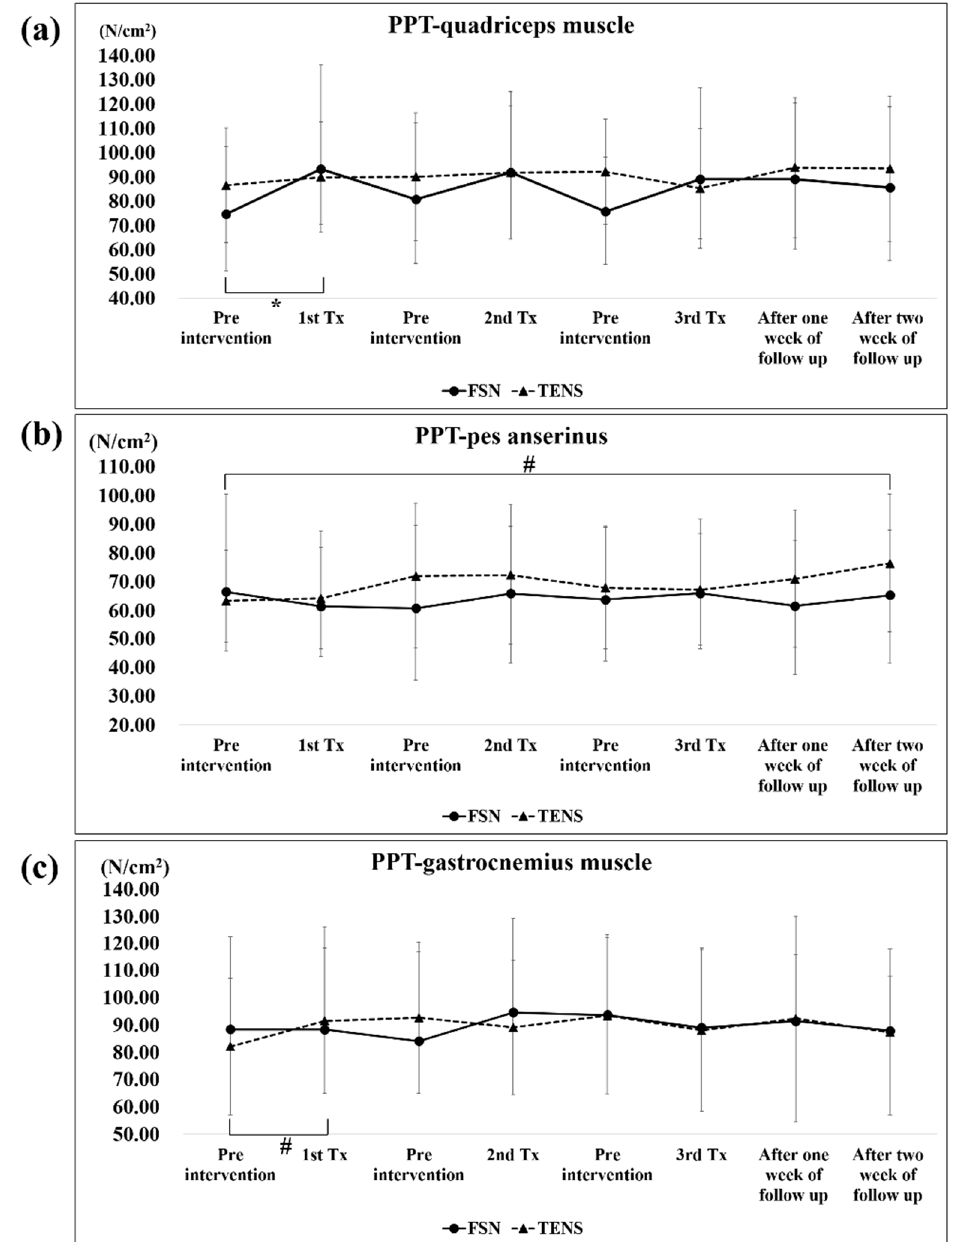
Figure 6. Comparison of the PPT of the quadriceps muscle ( a ), pes anserinus ( b ), and gastrocnemius muscle ( c ) between the two groups after each treatment. * represents the FSN group p < 0.05; # represents the TENS group p < 0.05. PPT: pressure pain threshold; FSN: Fu’s subcutaneous needling; TENS: transcutaneous electrical nerve stimulation.